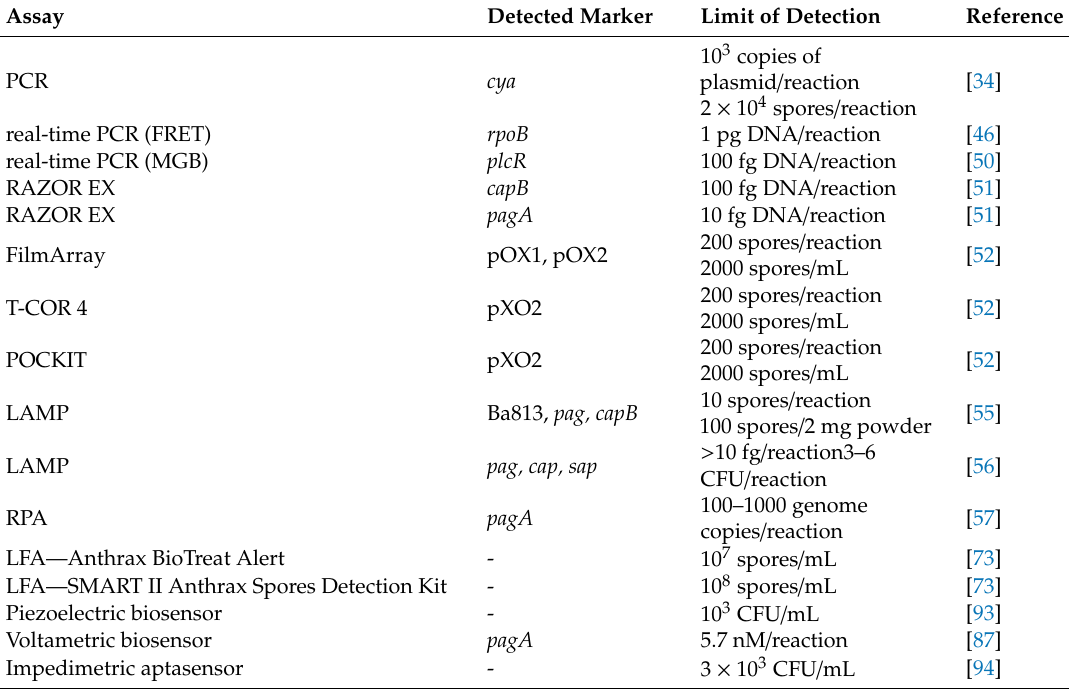
Table 1. Comparison of detection limit for selected B. anthracis detection